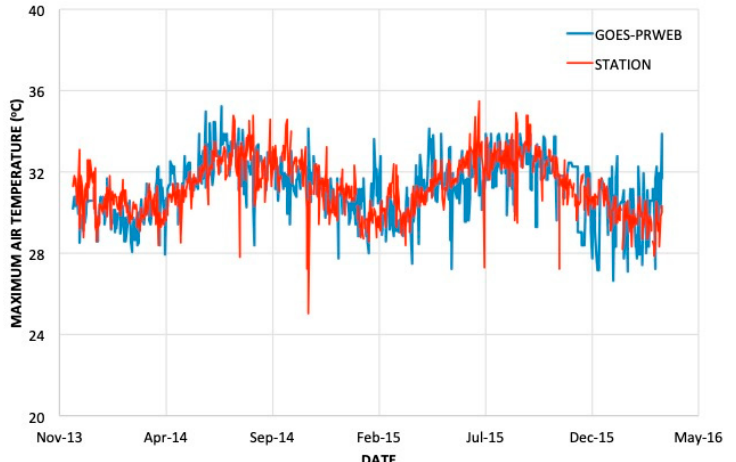
Figure A2. Modeled and observed T max from January 2014 to April 2016 at the UPR Agricultural Experimental Station near Juan Diaz, Puerto Rico.